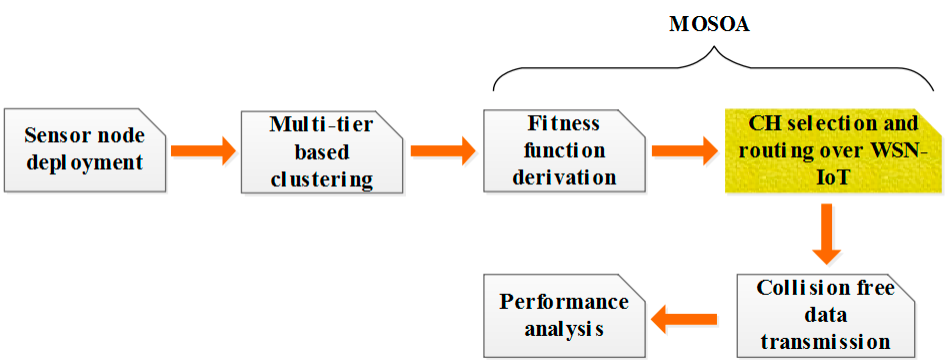
Figure 3. Overall block diagram of WSN-IoT.